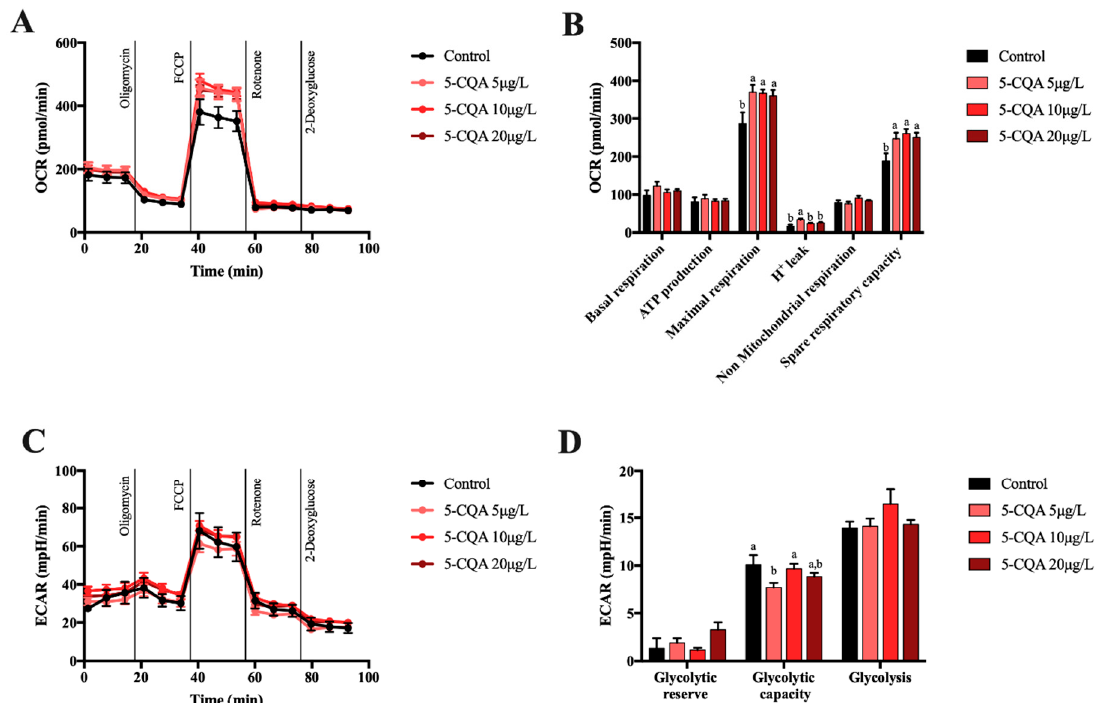
Figure 3. Oxygen consumption rate (OCR) ( A ), mitochondrial function parameters ( B ), extracellular acidification rate (ECAR) ( C ), and glycolytic parameters ( D ) in mouse primary hepatocytes incubated for 18 h with different concentrations of 5-CQA. Each bar represents the mean ± SEM of three independent experiments and analyzed by one-way ANOVA followed by Tukey multiple comparison post hoc test. The differences were considered statistically significant at p < 0.05. Mean values with different lowercase letters show statistical differences between each other.